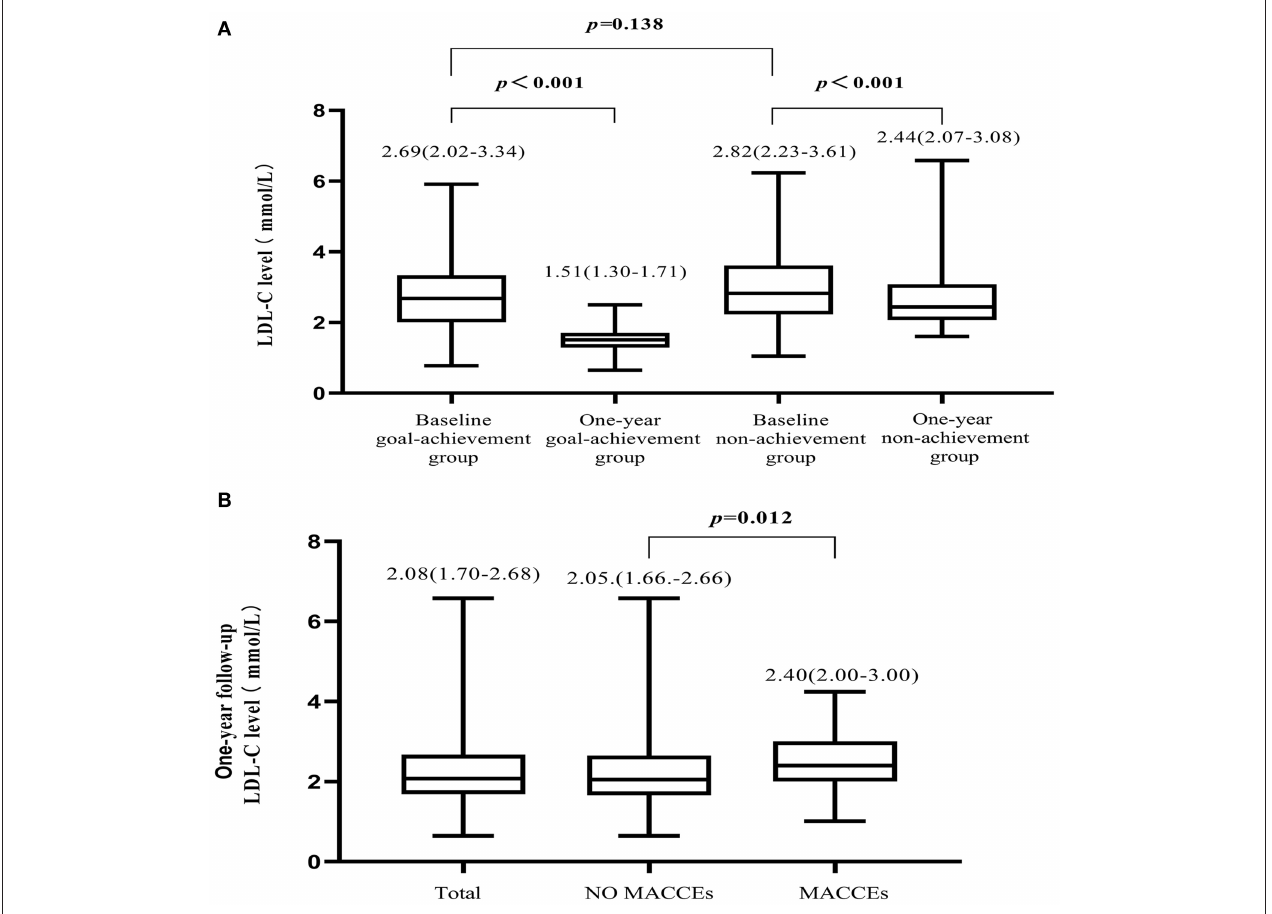
FIGURE 2 | Variation in LDL-C level. (A) Compared to baseline, LDL-C levels were reduced in both the goal-achievement and non-achievement groups at the 1-year follow-up. (B) LDL-C levels at the 1-year follow-up in all patients, patients with MACCEs, and patients without